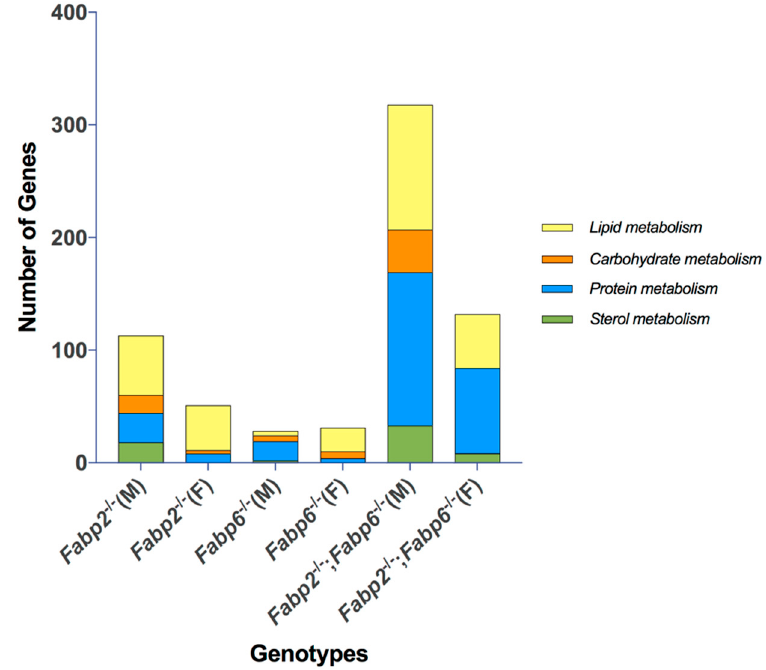
Figure 3. The comparison of the numbers of DE genes involved in key nutrient metabolism processes. The biological processes that comprise the nutrient metabolism categories are listed in the Supplementary Table S2.